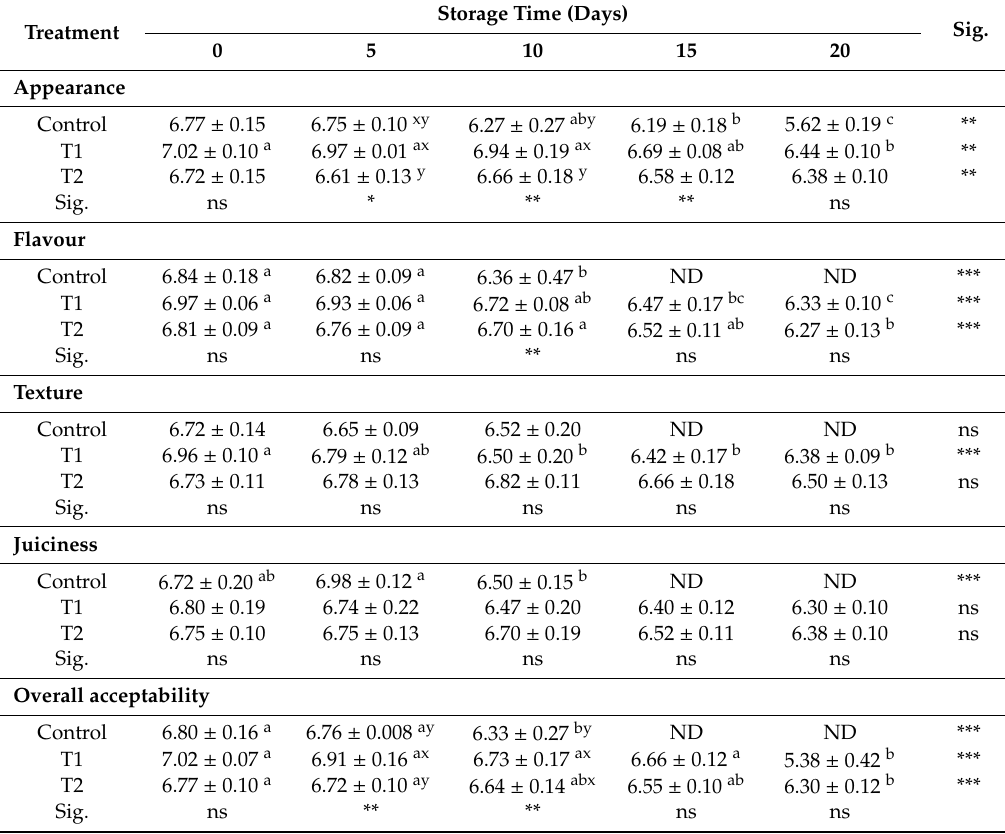
Table 6. E ff ect of Moringa flower on sensory attributes of chicken nuggets during the storage time (mean values ± error standard of six samples). Control = no additive; T1 = 1.0% Moringa flower extract; T2 = 2.0% Moringa flower